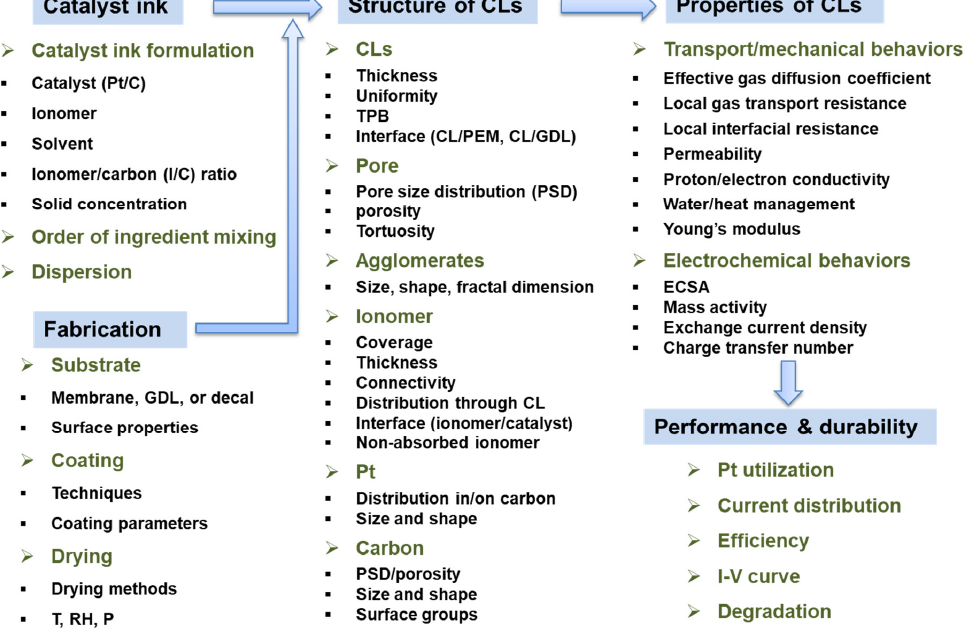
Figure 1. Material–structure–properties relation of the CL (T: temperature, RH: relative humidity, P: pressure, ECSA: electrochemical active surface area).